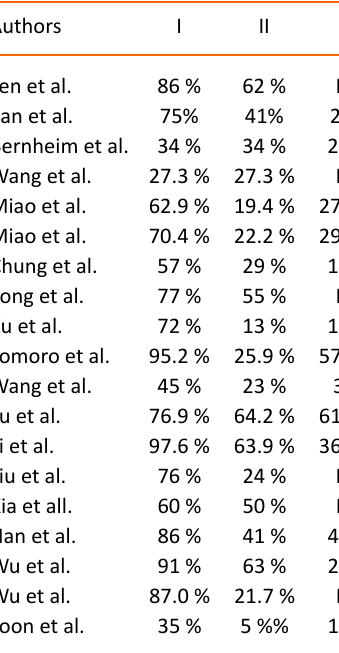
Table 3. Common reported CT scan findings in patients infected with COVID-19